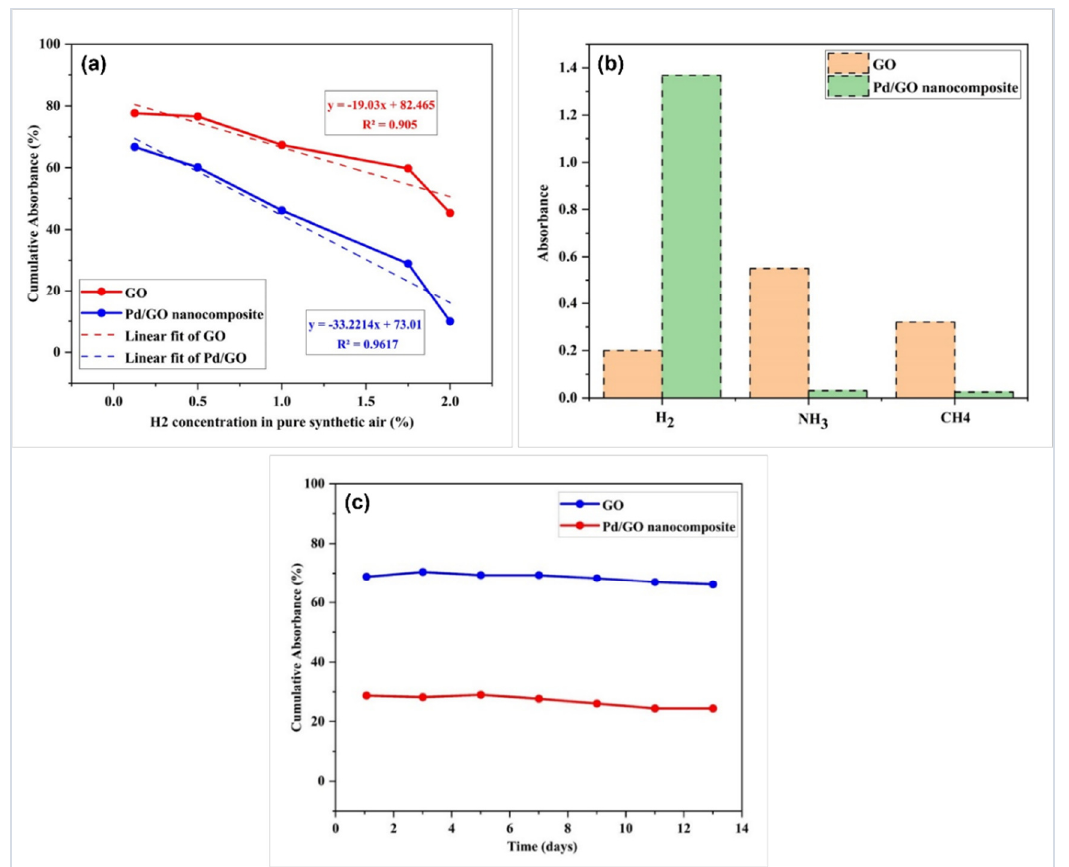
Figure 19. ( a ) Absorbance changes at different H 2 concentrations for coated GO and Pd/GO nanocomposite-based sensors, ( b ) comparison bar graph of the selectivity of optical fibers coated with GO and Pd/GO nanocomposite-based sensors, and ( c ) stability of the fabricated sensors towards 2.00% H 2 gas concentration in synthetic air at 100 °C. Table 1. Summary and comparison of the developed tapered optical fiber sensors’ sensing perfor- mance.